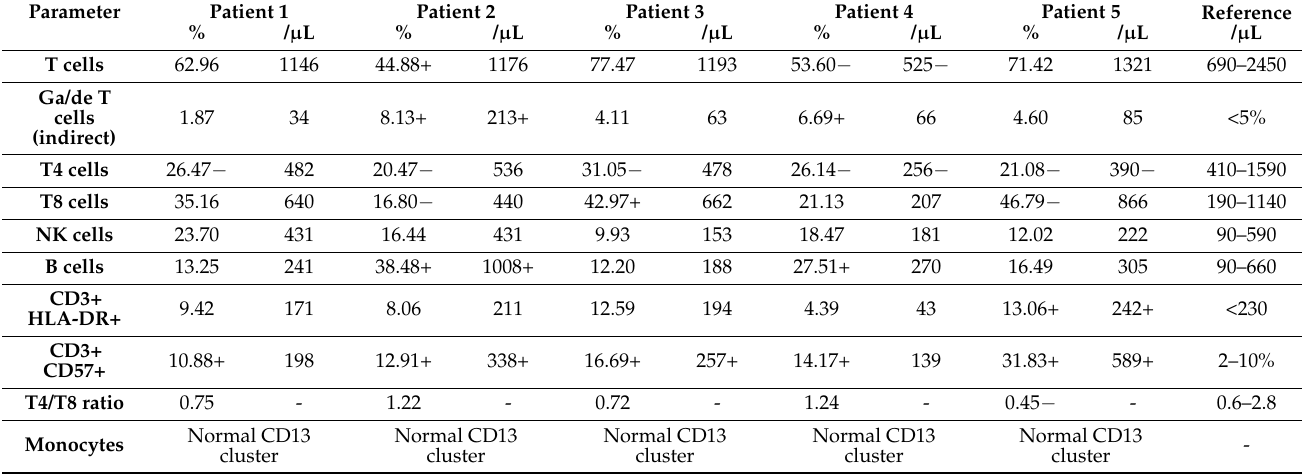
Table 4. Subtyping of lymphocytes with fluorescence-activated cell sorting of BKPyV viruria patients (n =